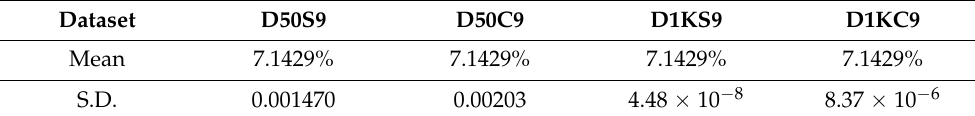
Table 2. Mean and Standard Deviation (S.D.) of the Dataset Global BDe Best Order percentage